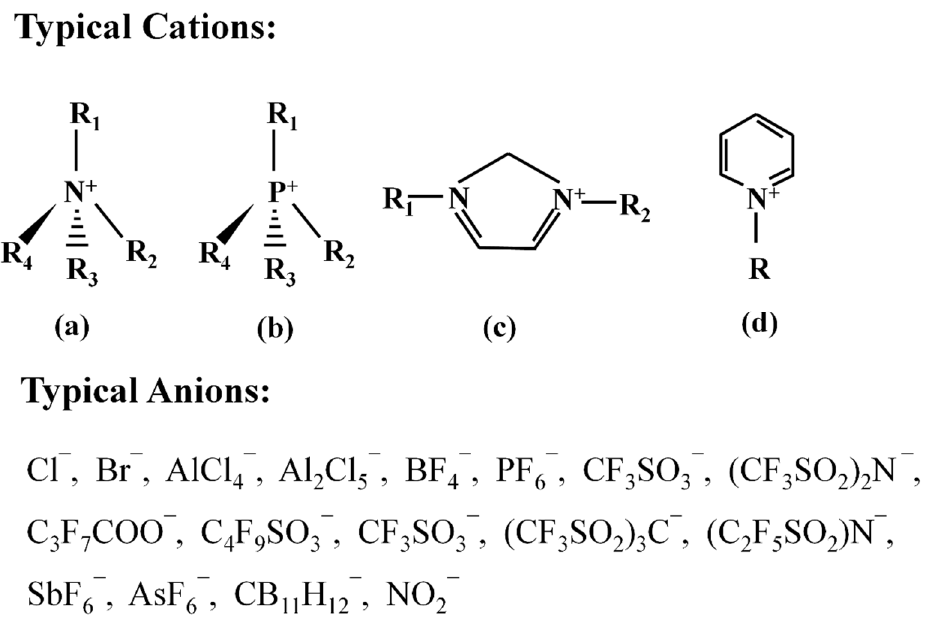
Figure 4. Typical anion and cation structures of common ILs: ( a ) quaternary ammonium salt ions; ( b ) quaternary phosphonium salt ions; ( c ) imidazole salt ions; ( d ) pyrrole salt ions, where R is a common anion.